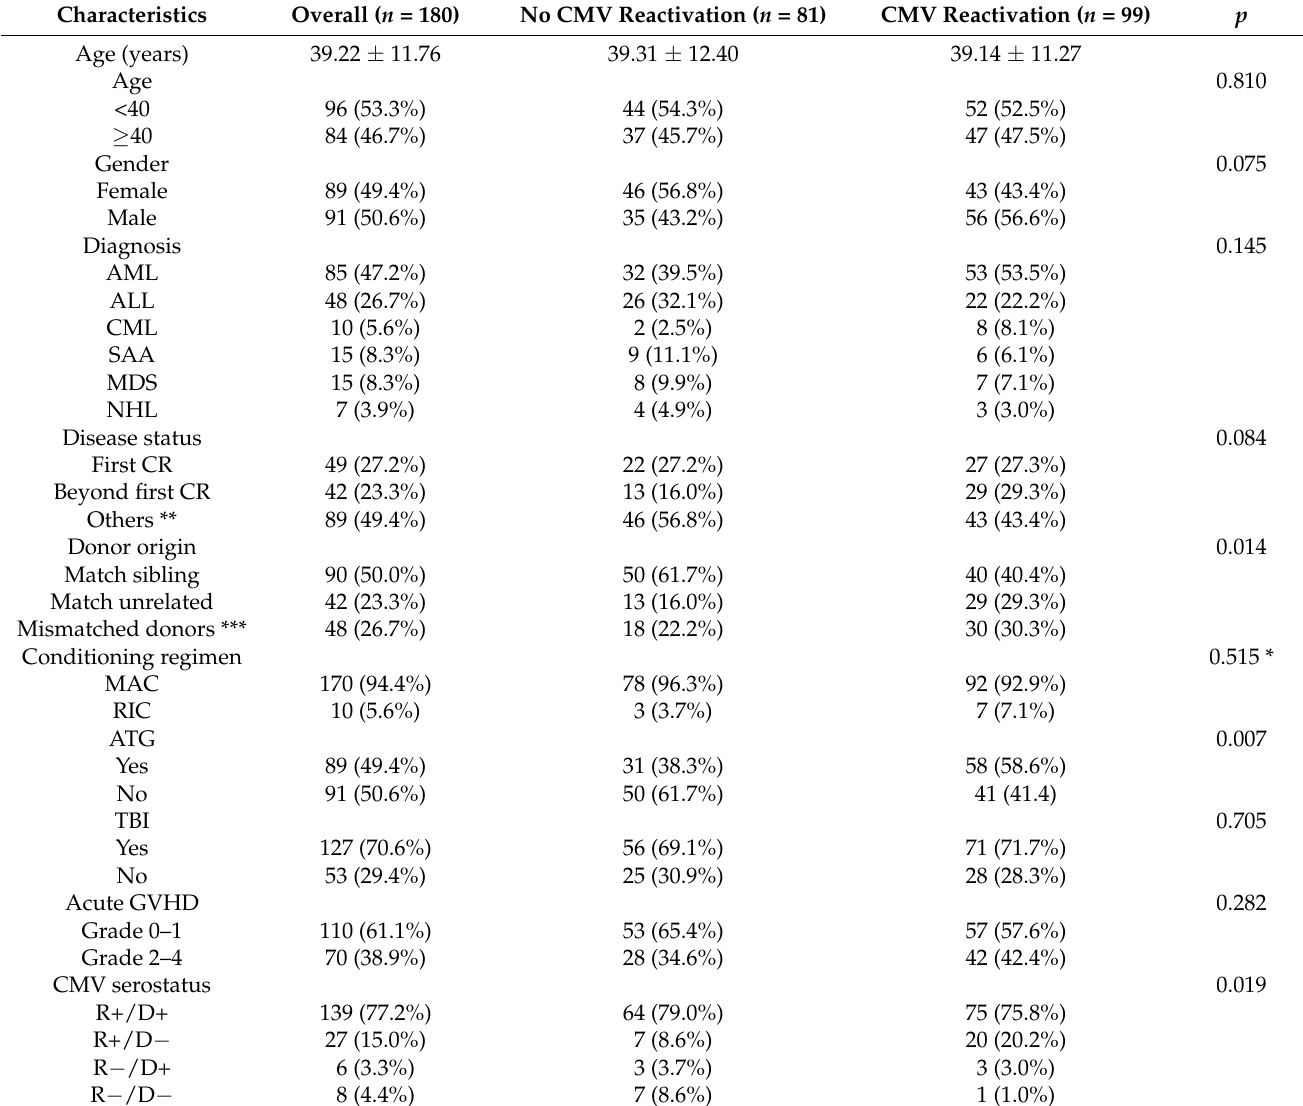
Table 1. Baseline characteristics of patients receiving